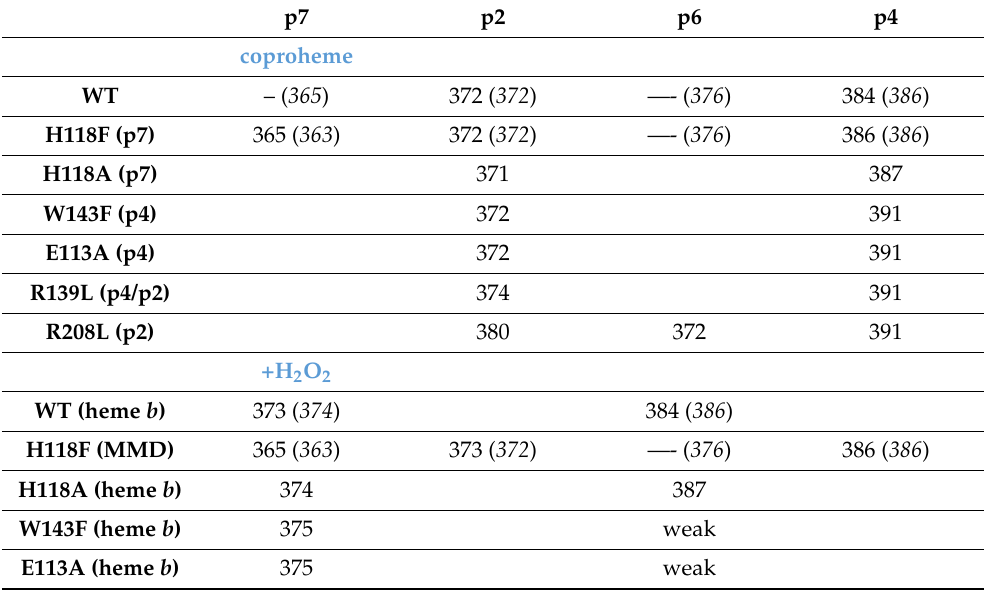
Table 2. Propionate bending mode wavenumbers (cm − 1 ), as observed in the RR spectra or according to the deconvoluted spectra (reported in italics in brackets) of WT and variants (see Figures 8 and